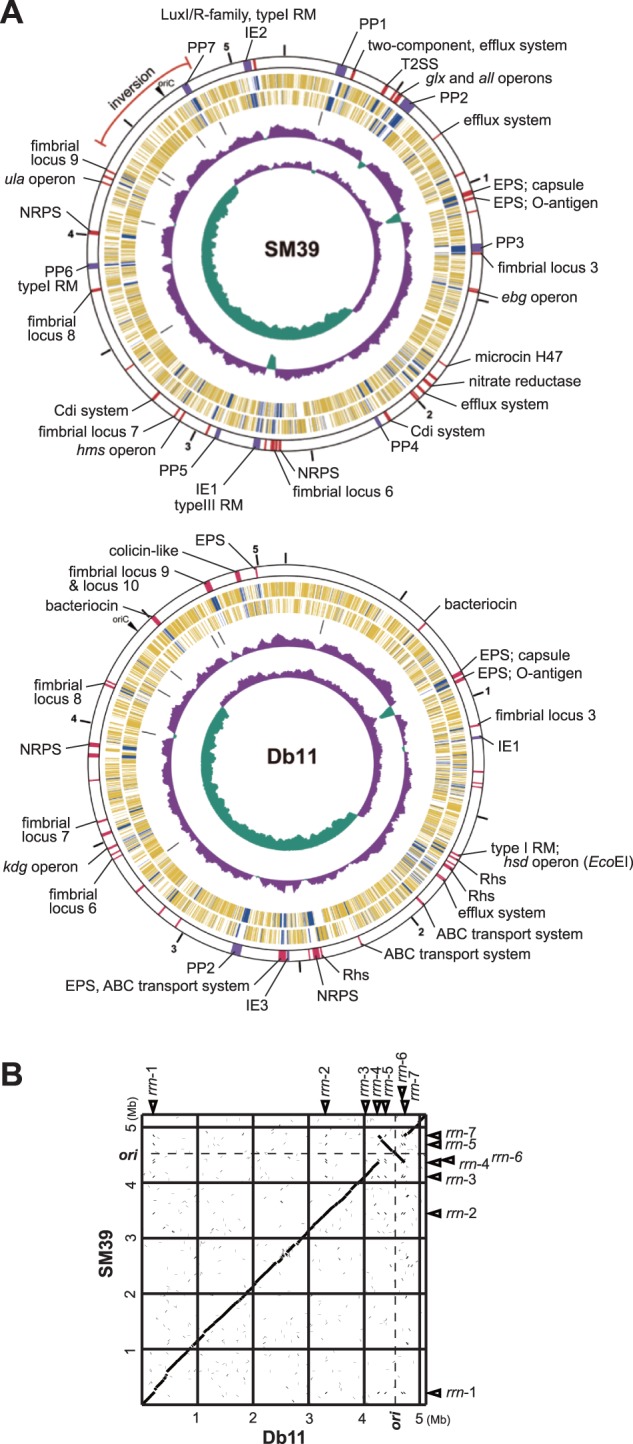
The chromosomes of Serratia marcescens strains SM39 and Db11. (A) Circular maps of the SM39 and Db11 chromosomes. From the outside in, the first circle shows the nucleotide sequence positions (in Mb), and the second circle shows the locations of strain-specific regions of ≥5 kb (purple: prophages and integrative elements; red: others) with an indication of their features and/or encoded products/functions (PP, prophages; IE, integrative elements; EPS, exopolysaccharide biosynthesis). The third and fourth circles show CDSs transcribed clockwise and anticlockwise, respectively (yellow: CDSs conserved in both strains, blue: CDSs specific to one strain), the fifth circle the rRNA operons, the sixth circle the G+C content, and the seventh circle the GC skew. (B) Dot plot presentation of DNA sequence homologies between the chromosomes. Locations of ori and seven rRNA operons (rrn1–rrn7) are indicated.